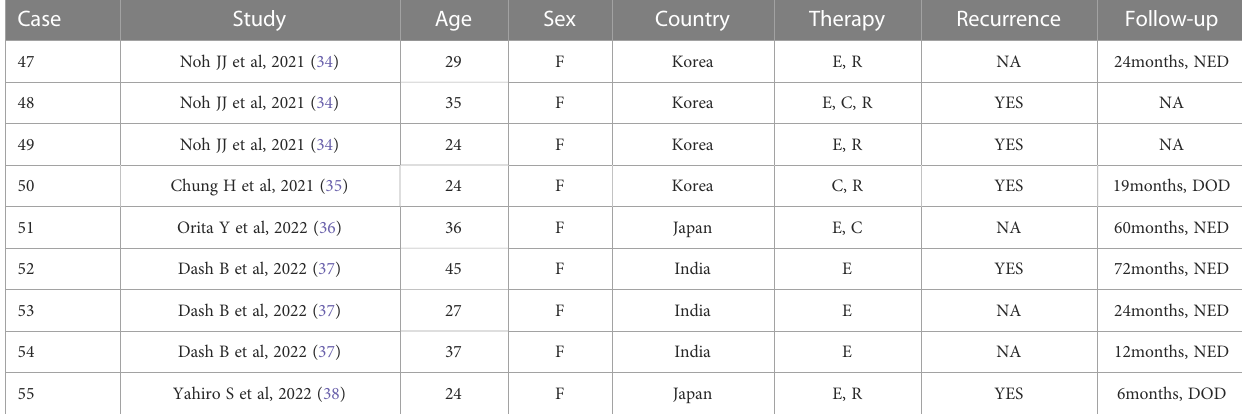
(MRI) revealed a well-circumscribed solid and homogeneous lump in the right perineum (Figure 1). Positron emission tomography- computed tomography (PET-CT) for initial staging showed a heterogeneous hypermetabolic mass in the right perineum and a fi stula in the lump (Figure 2). However, no bone or skin involvement or lung or liver metastases were noted. His medical history was unremarkable. The patient underwent complete resection with negative margins of the tumor through a perianal incision and avoided damaging the rectum and anal sphincter, followed by 25 courses of adjuvant radiotherapy at a dose of 50 Gray targeting the right perineum. Speci fi cally, the mass was excised with all margins free of tumor, and there was about a 1-cm distance between the tumor lesion and the excised margin in all directions.